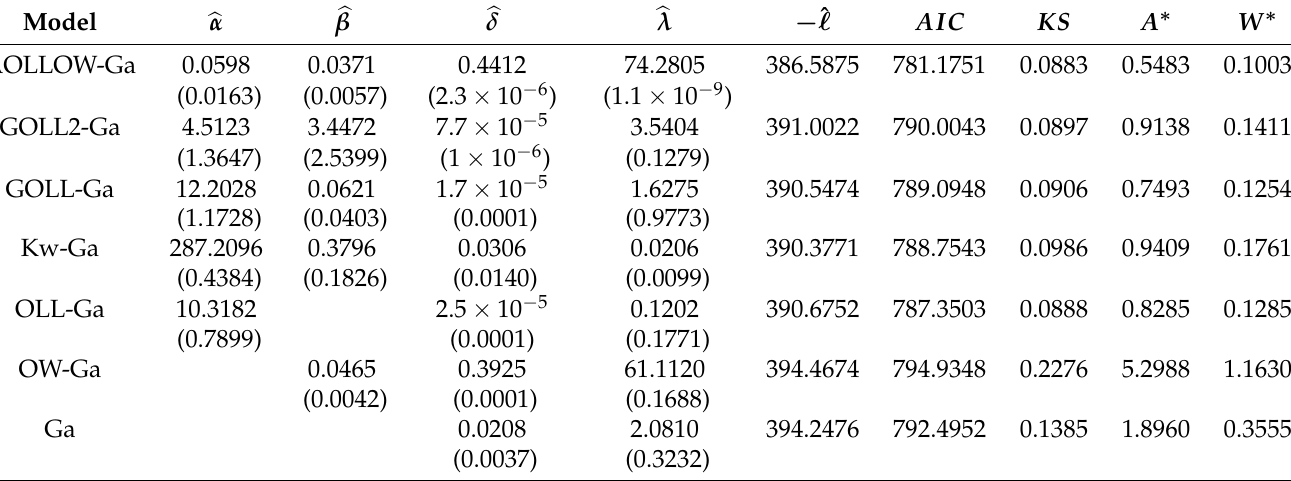
Table 3. The results of the second data set (standard errors of the estimates are in parentheses).